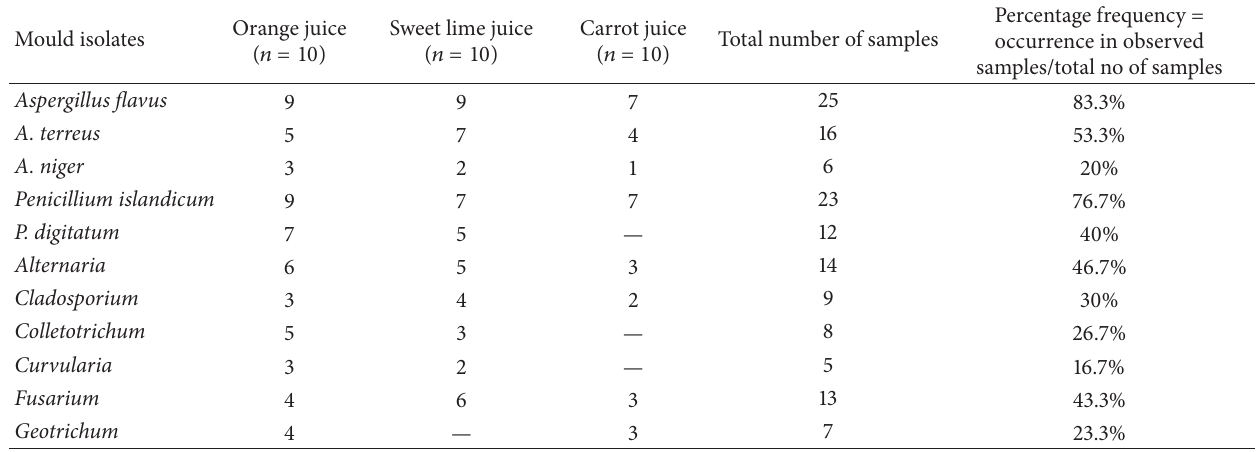
Table 10: Percentage abundance of mould isolates in juice